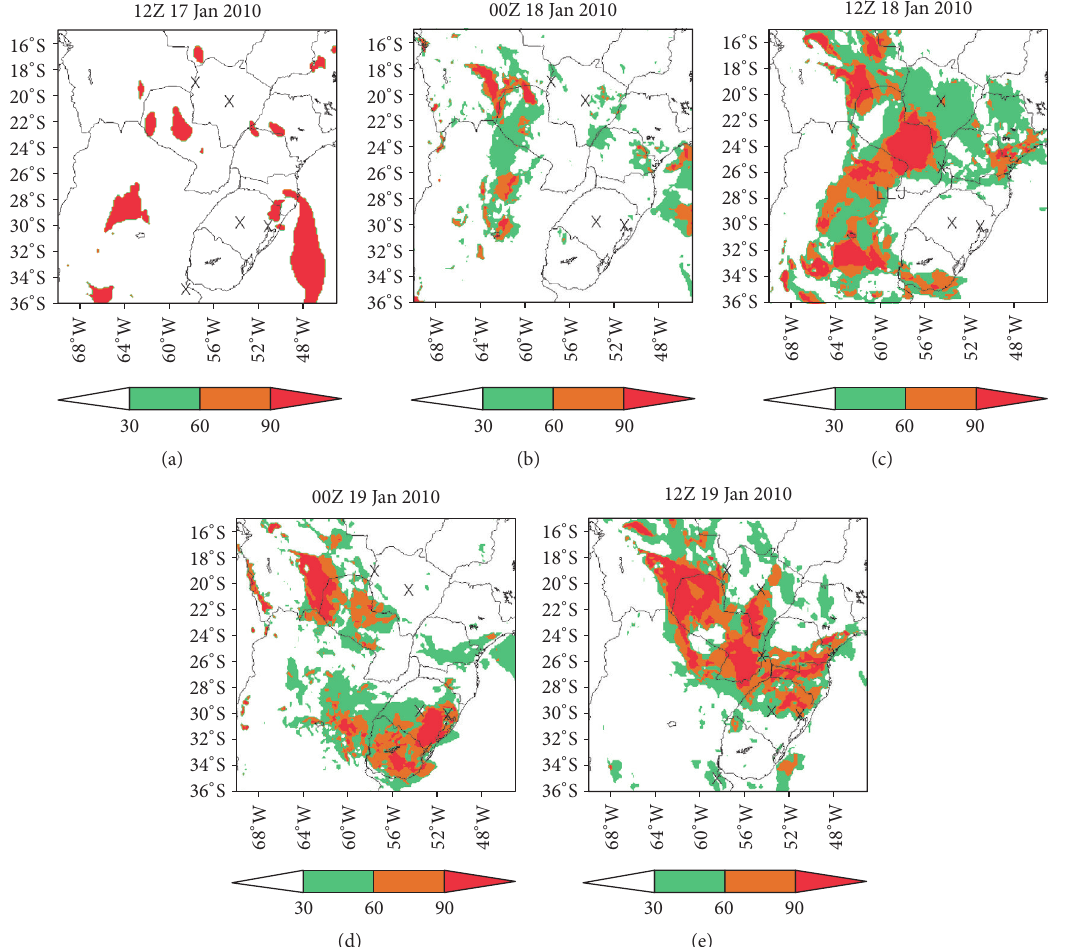
Figure 20: As in Figure 16 but for the simulations employing the YSU PBL parameterization scheme and from (a) 12Z 17 January 2010 (model initial condition) to (e) 12Z 19 January